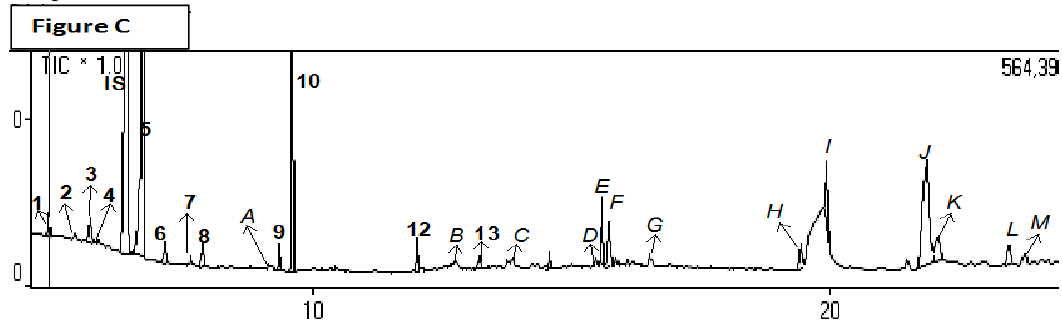
ounds after 1h inhalation, and figure C shows the chromatogram of essential compounds after 2h inhalation. IS : Internal Standard. The peak which is indicated by A to M is such compounds other than essential oil (Table